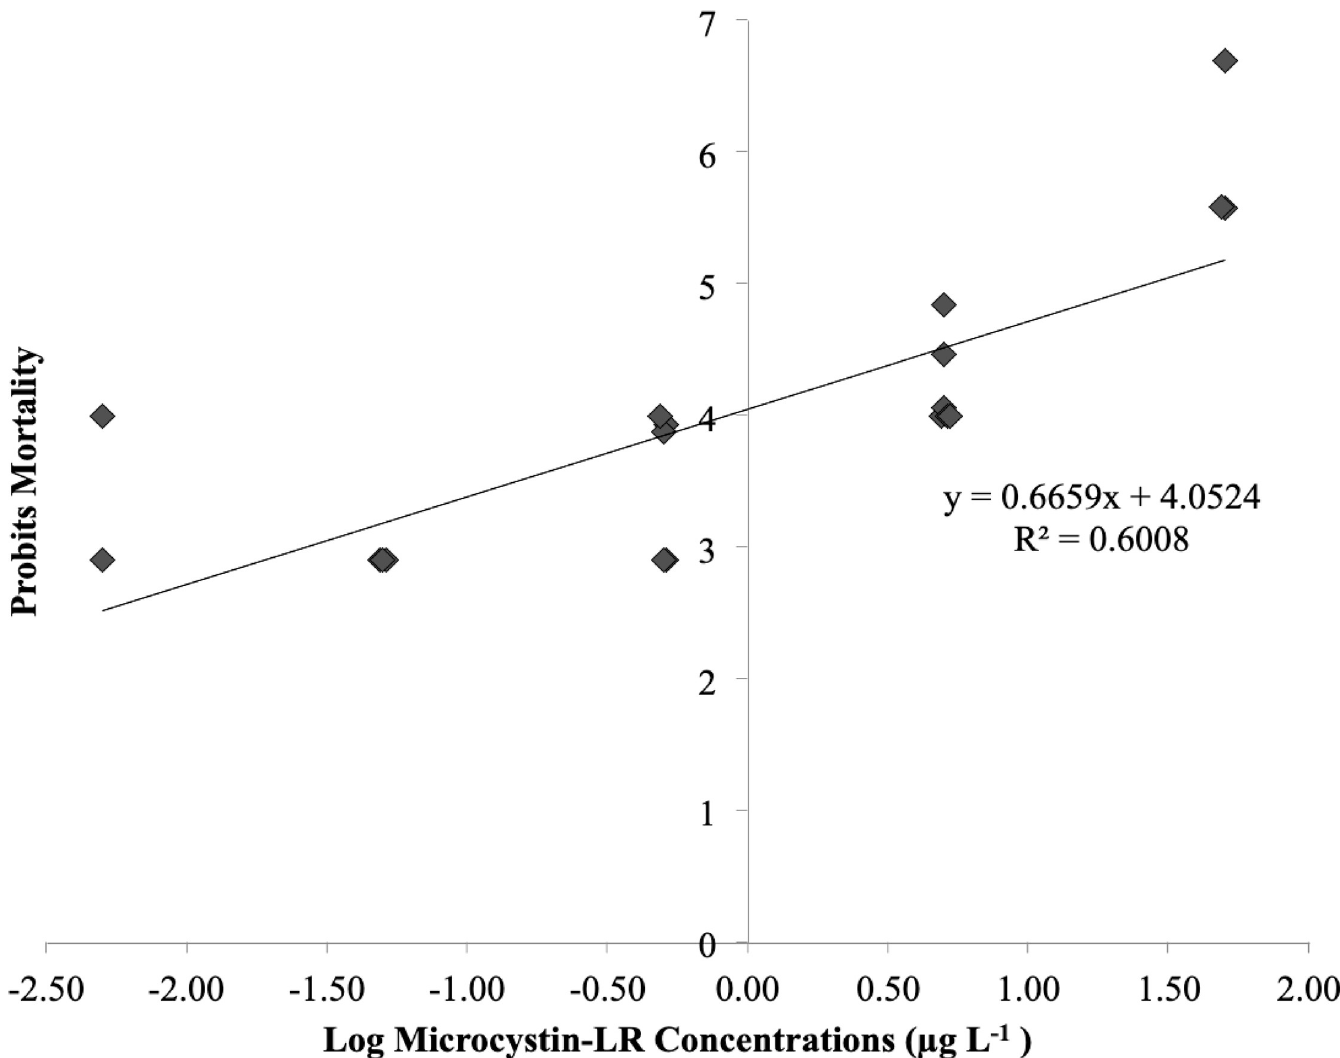
Fig 2. Probit analysis of the effect of microcystin-LR on B . longirostris mortality. Percent mortality converted to empirical probits versus log of the microcystin-LR concentrations [36]. Log-LC 50 = 1.42, based on linear regression with 100 μ g L -1 concentration treatment omitted: y = 0.6666x+4.0531. R 2 = 0.602. LC 50 = 26.3 ± 4.6 μ g L -1 .